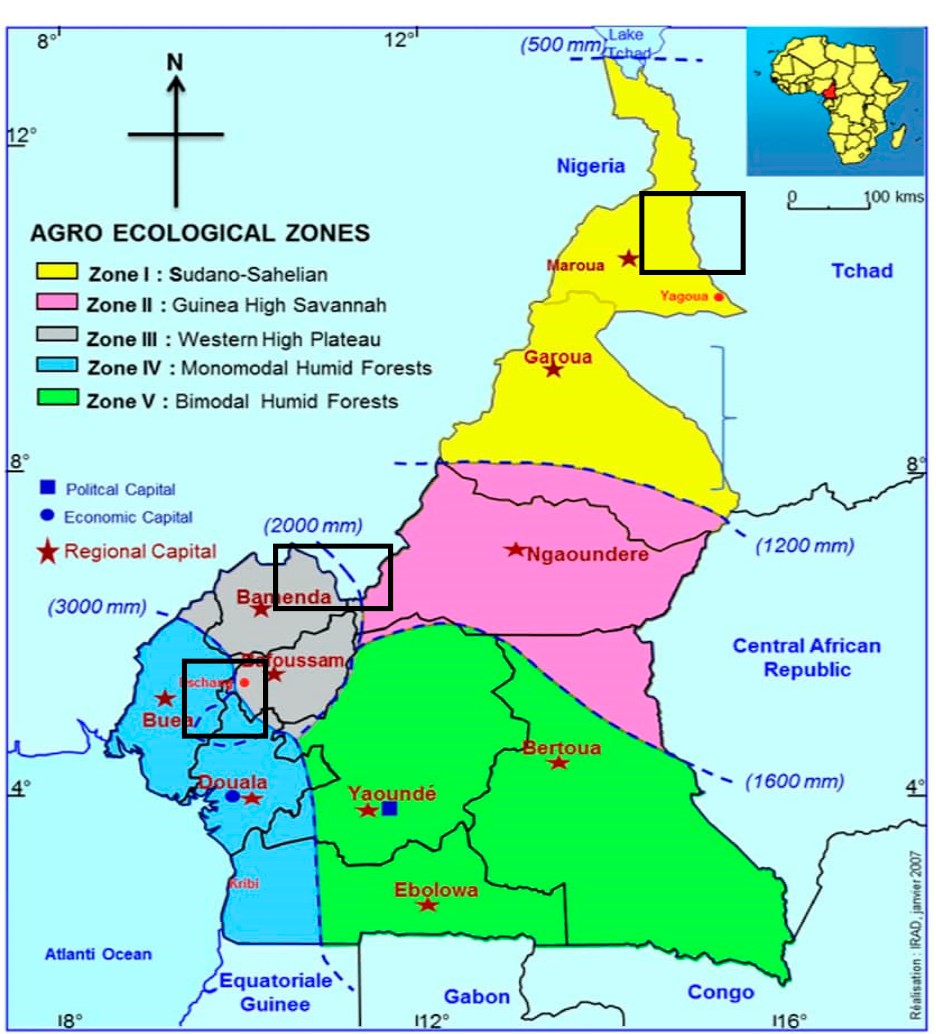
Figure 2. Geo-ecological zones in Cameroon and regions covered. Source: DSDSR ([59], p. 113). Notes: Black boxes represent the study regions in the three selected geo-ecological zones, represented by the regional capitals Maroua, Buea and Bamenda, respectively.